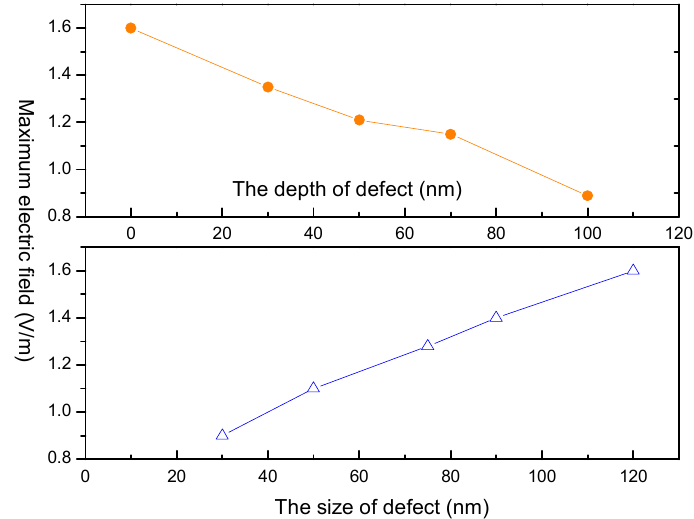
Figure 3. Light field intensification as a function of geometry parameters. In addition, the local light field intensification induced by defects is also closely related to the relative refractive index between the defect and the film layer. Figure 4 shows that the higher relative refractive index between the defect and the film layer induced a higher peak light field intensification, where the defect was located in the film and lodged at a depth of 50 nm from the film layer surface. At the same time, the local light field intensification induced by the defect also depended on the extinction coefficient of the defect. Additionally, the higher the extinction coefficient of the defect, the stronger the light field intensifications were, as shown in Figure 5.